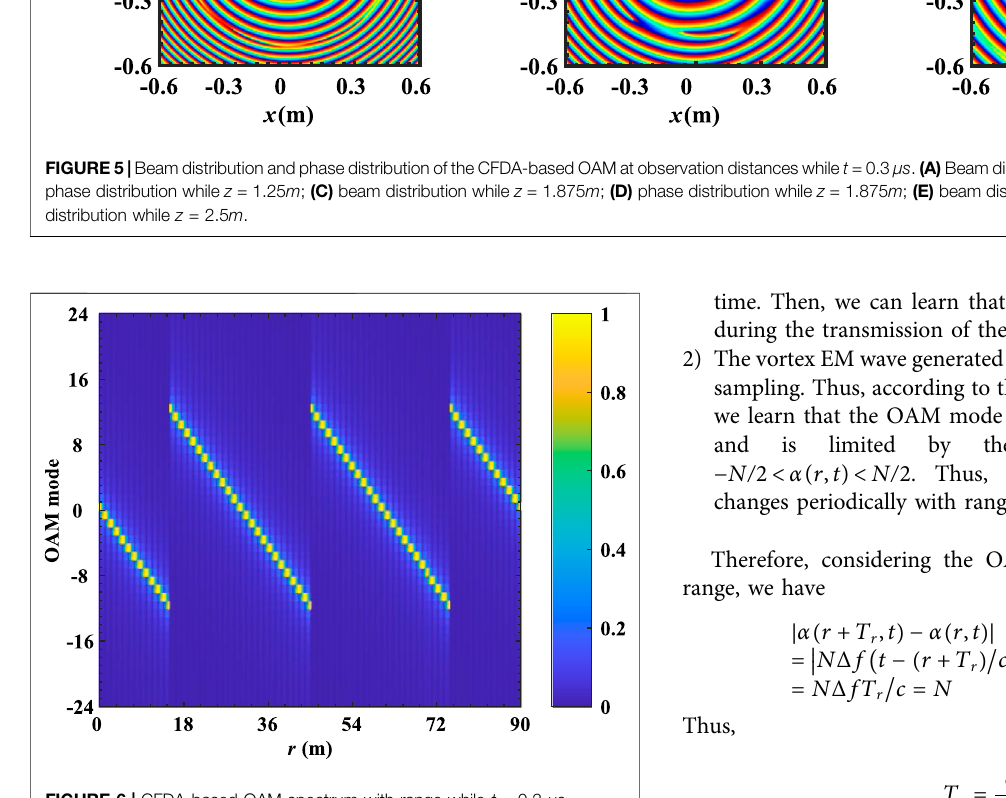
FIGURE 6 | CFDA-based OAM spectrum with range while t = 0.3 μ s